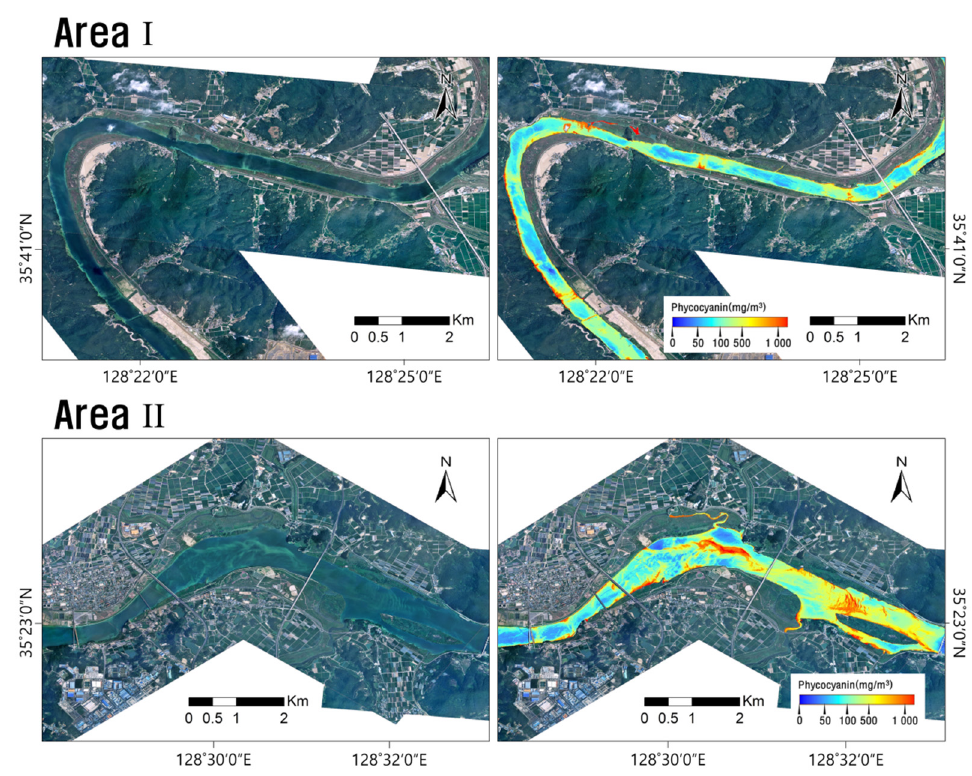
Figure 10. Comparison of estimated PC concentrations ( right ) and corresponding RGB images ( left ) at selected areas along the Nakdong River.